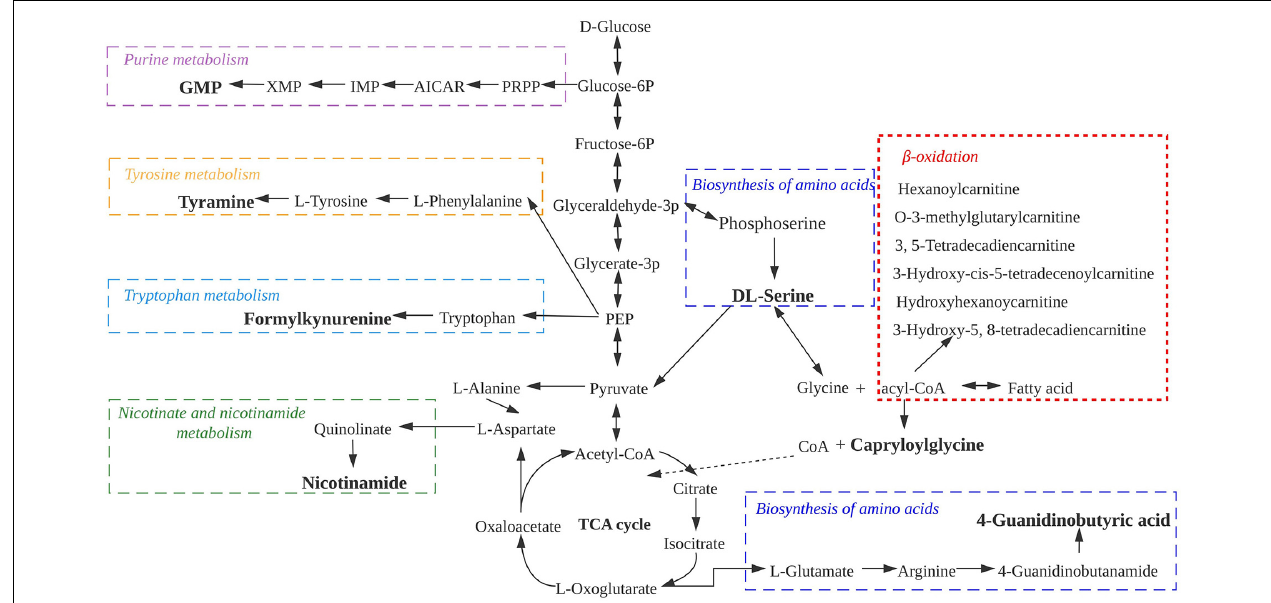
FIGURE 6 | Metabolic pathways of differential non-volatile metabolites in low-temperature